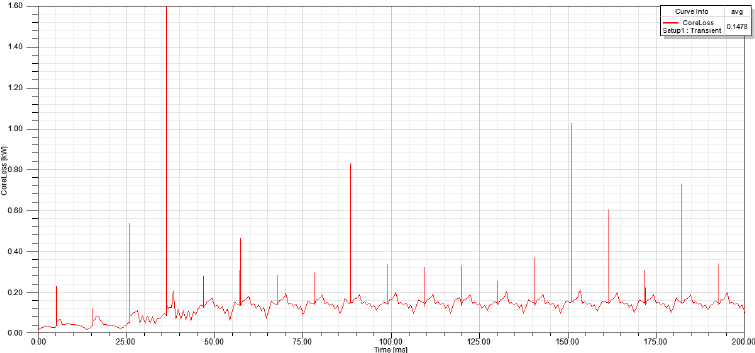
Figure 21. Time domain curve of eddy current loss of permanent magnet.